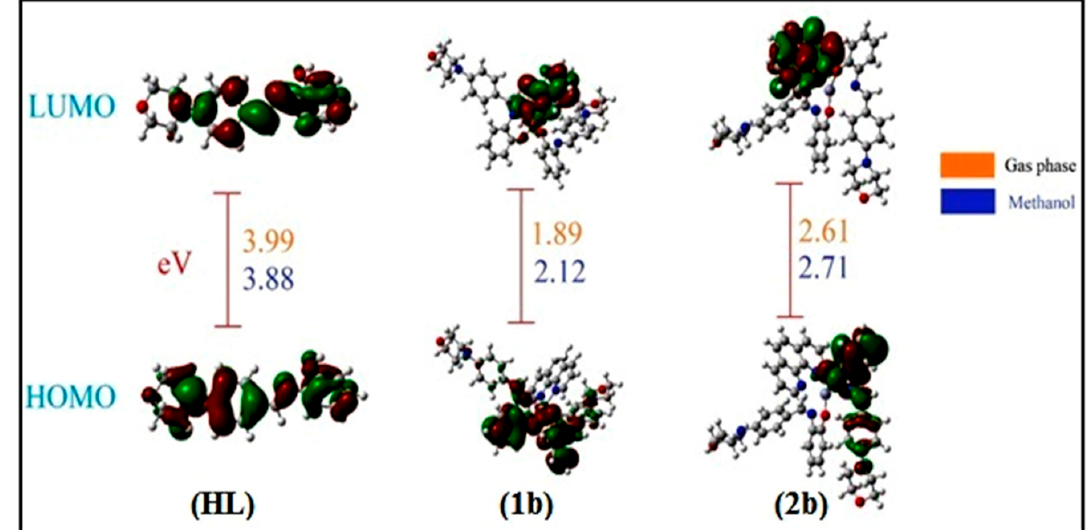
Figure 9. The frontier molecular orbitals of the free ligand ( HL ) and complexes ( 1b – 2b ). HOMO- LUMO gaps in the gas phase and methanol are provided.